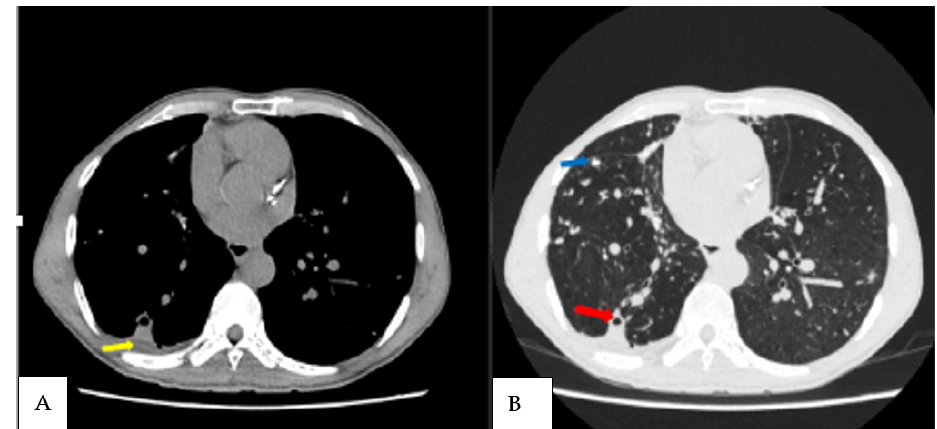
Figure 4. Axial non contrast CT scan, axial mediastinal and lung windows of the chest of the third CPA patient diagnosed at T 3 patient, demonstrating ( A ) right lung nodules (blue arrow); ( B ) small right lower lobe cavity with pericavitary infiltration (red arrow) as well as a small pleural effusion (yellow arrow).